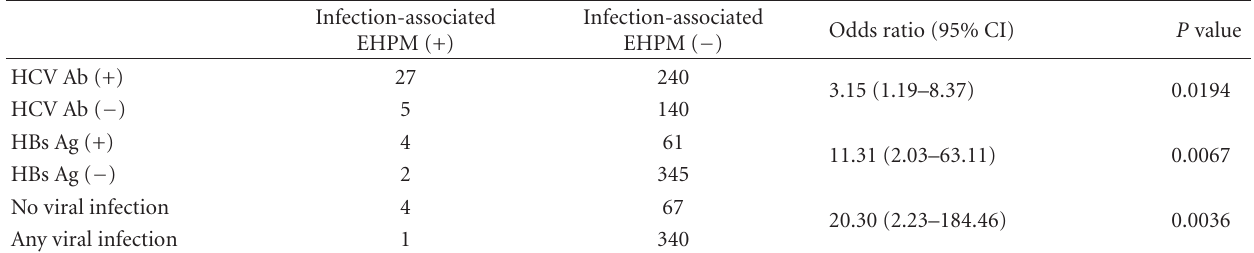
Table 4: Odds ratios for infection-associated EHPM † according to viral infection